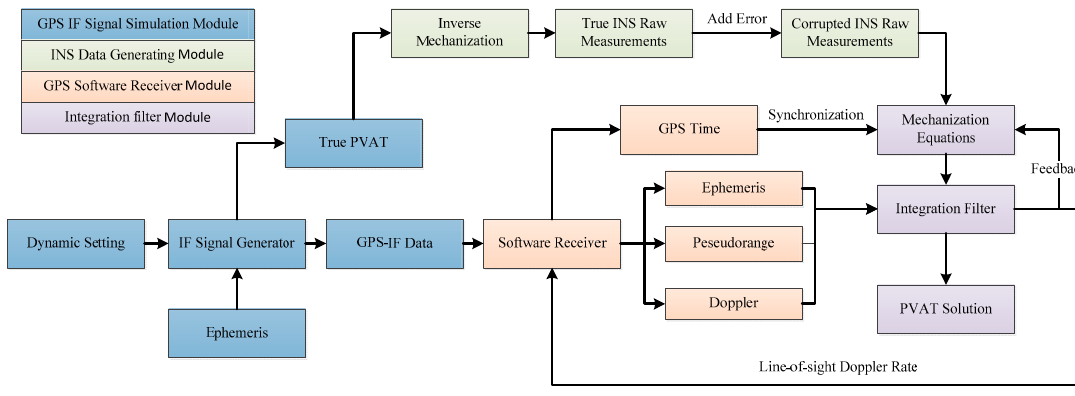
Figure 6. The block diagram of software simulation platform.